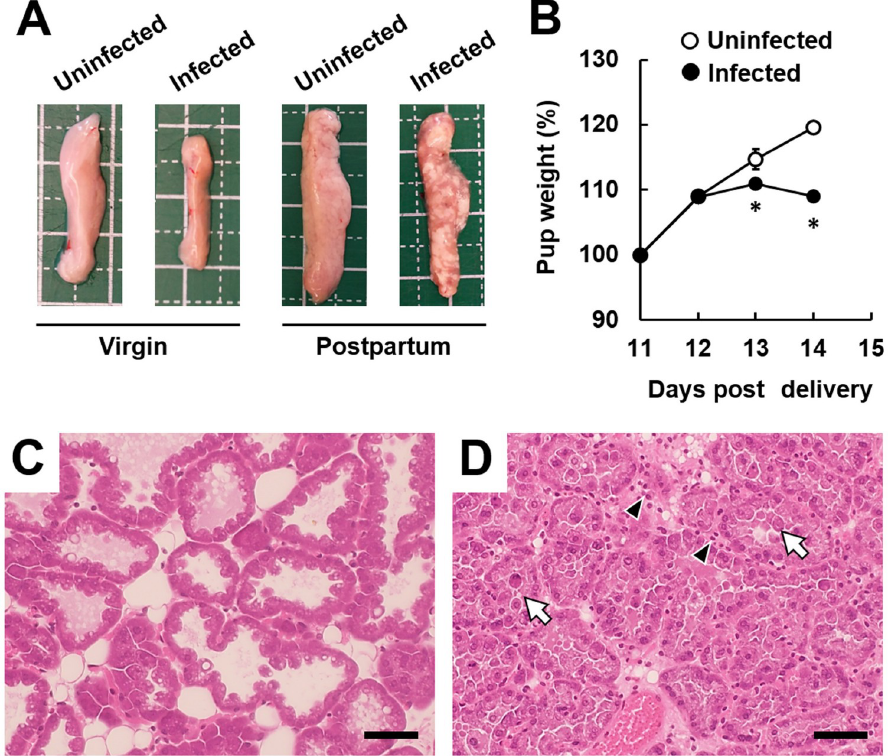
Fig 2. Development of mastitis in postpartum mice infected with malaria parasites. B6 mice on day 7 post-delivery were injected with 1 × 10 4 infected erythrocytes of luciferase-expressing Plasmodium berghei ( Pb ) ANKA. (A) Macroscopic analysis of mammary gland tissue. Mammary gland tissues were removed on day 14 post-delivery (on day 7 post-infection). Experiments were performed in triplicate with similar results. Representative data are shown. (B) Pup weight. The weight is expressed as a percentage of the value on day 11 post-delivery. Results are expressed as means ± standard deviation (SD) of pups delivered by the mother. Experiments were performed in triplicate with similar results. Asterisks indicate a significant difference ( P < 0.05, compared with pups delivered by uninfected mice; Student’s t -test). (C and D) Histological analyses of mammary gland tissue on day 14 post-delivery. (C) Uninfected postpartum mice. (D) Infected postpartum mice. Representative hematoxylin and eosin (H&E)-stained tissue sections are shown. The scale bar represents 50 μ m. Arrows indicate destruction of an alveolus wall. Arrowheads indicate extensive presence of leukocytes. Experiments were performed in triplicate with similar